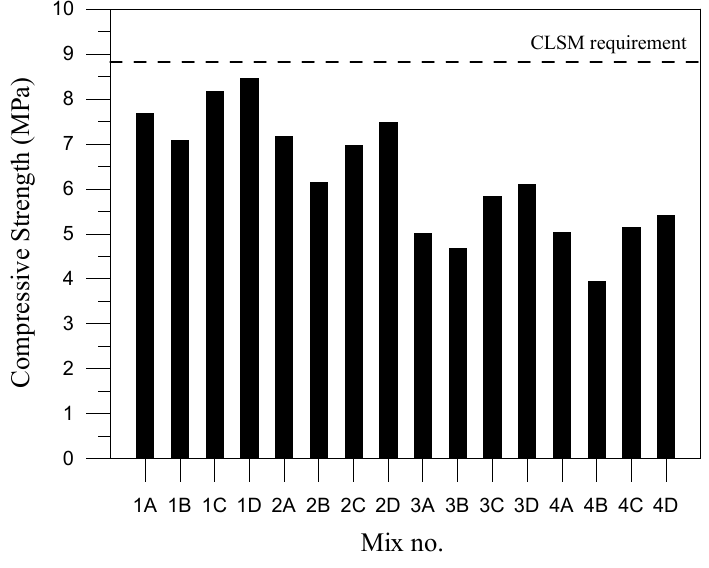
Figure 4. Compressive strength histograms.